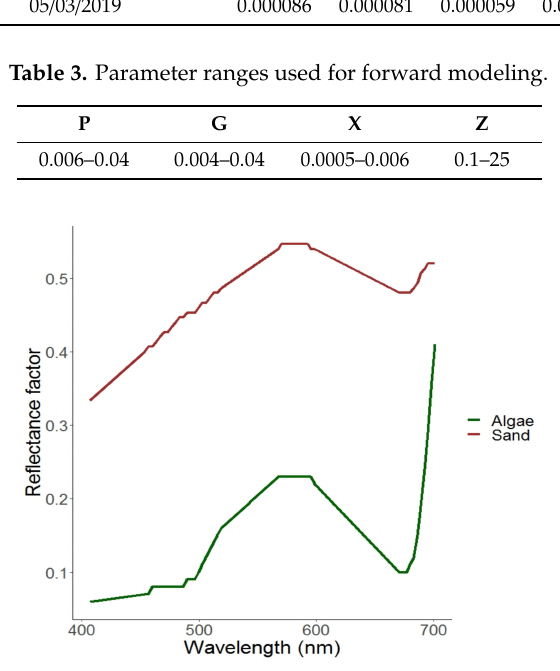
Figure 3. Spectral reflectance of the seafloor used in this